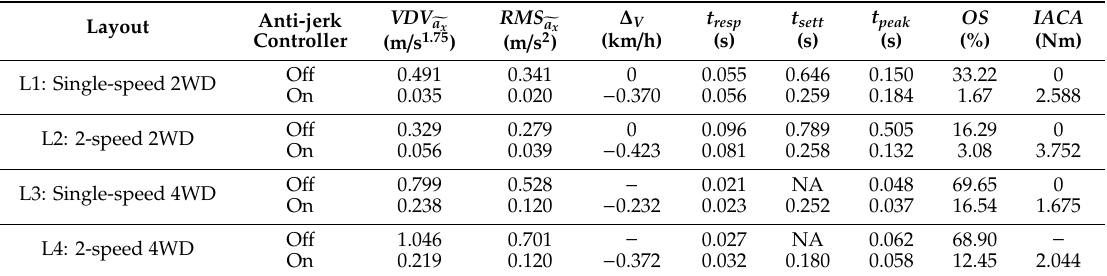
Table 3. Drivability performance indicators for the tip-in test of Figure 8.